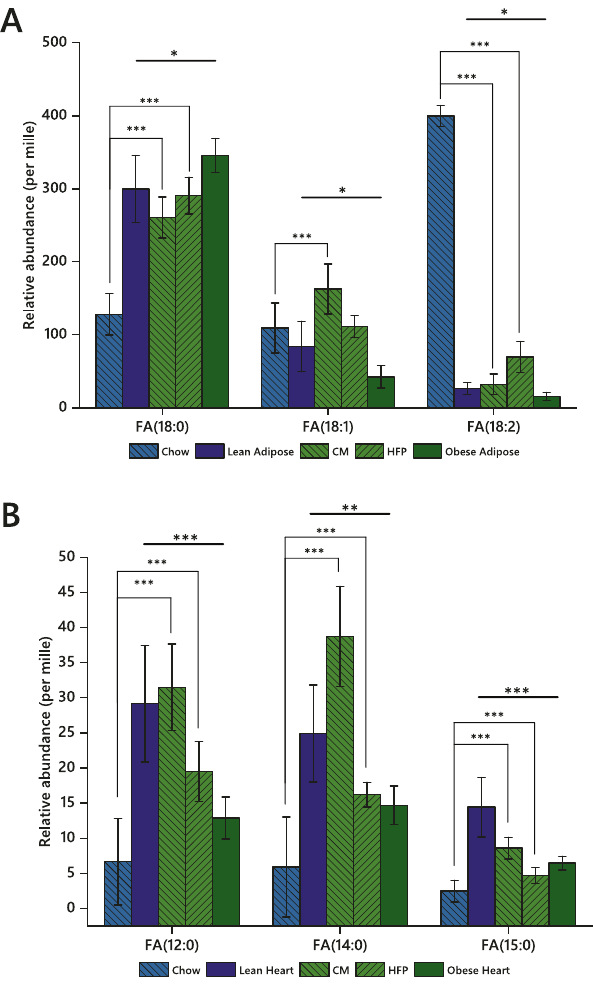
Fig. 4 Relative abundance of FAs in chow and high fat diets and tissues from lean and obese groups. A Adipose tissue. B Heart tissue. * p < 0.05; ** p < 0.005; *** p < 0.001. CM, condensed milk; FA, fatty acid; HFP, high fat